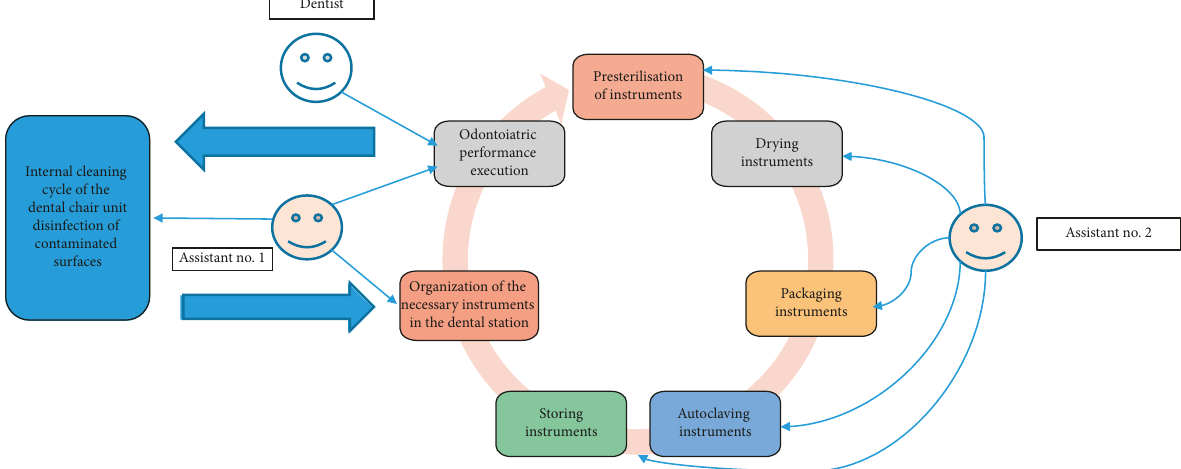
Figure 2: Sterilisation and disinfection cycle of dental instruments and dental station.